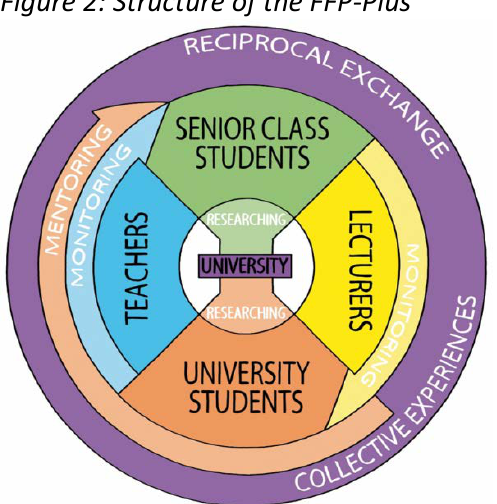
Figure 2: Structure of the